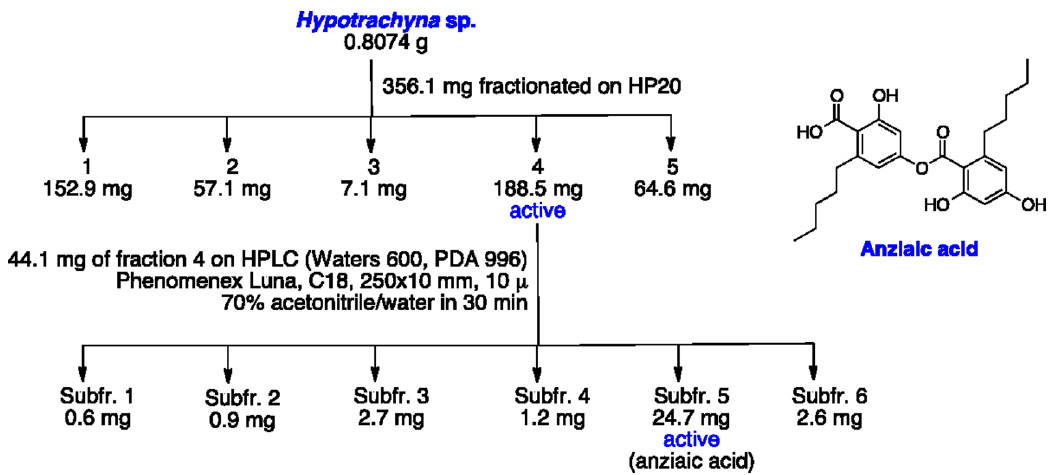
Figure 1. Isolation tree of anziaic acid.